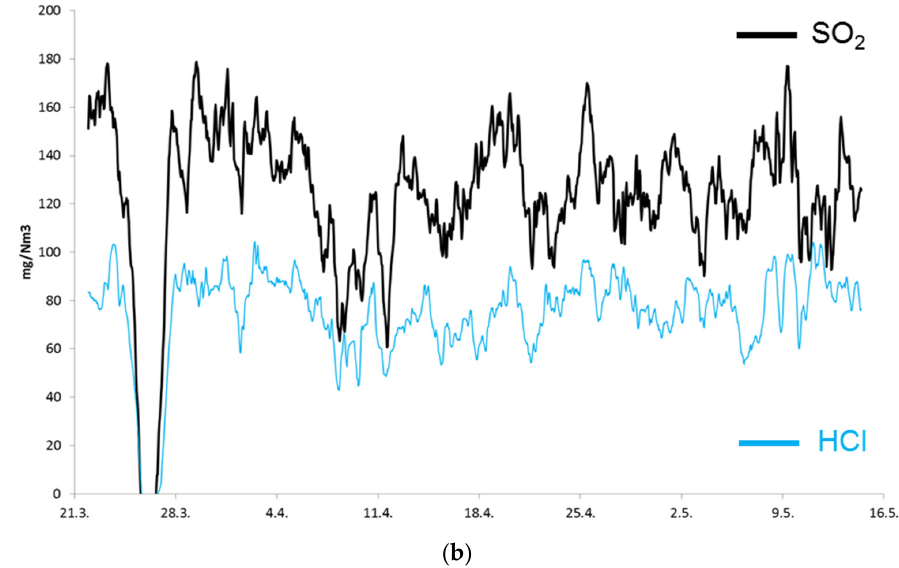
Figure 3. Process data during the test exposure: ( a ) Plant electricity output (MW) and flue gas temperature ( ◦ C) at the cyclone; ( b ) Flue gas data of sulfur dioxide SO 2 and hydrogen chloride HCl during the test (mg/Nm 3 ).